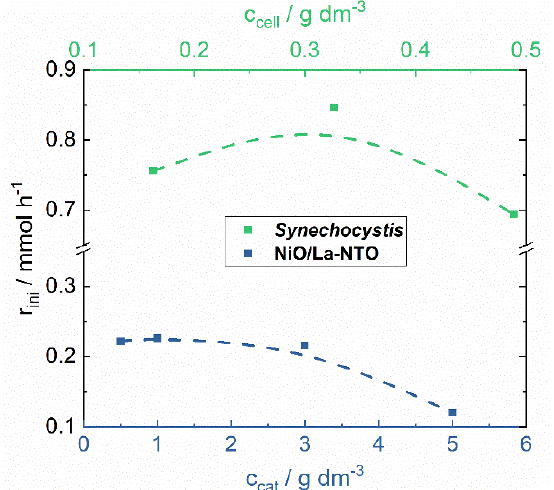
Figure 1. Initial O 2 evolution rate of Synechocystis (green) and initial H 2 evolution rate (blue) of NiO/La-NTO under full light spectrum (without a light filter) at their respective light intensity for maximum photocatalytic activity, i.e., 10 mW cm −2 for Synechocystis and 200 mW cm −2 for NiO/La-NTO.